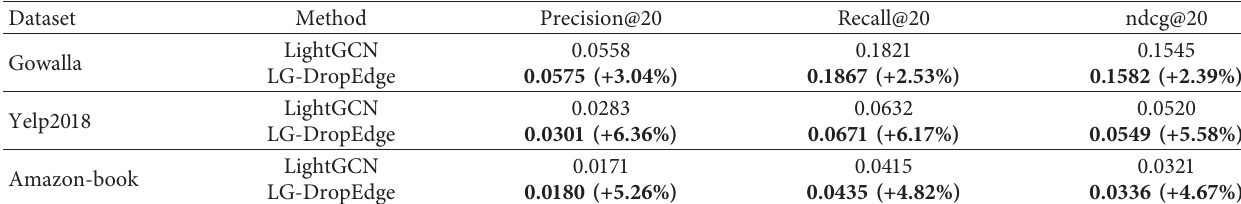
Table 2: Performance comparison of LG-DropEdge and